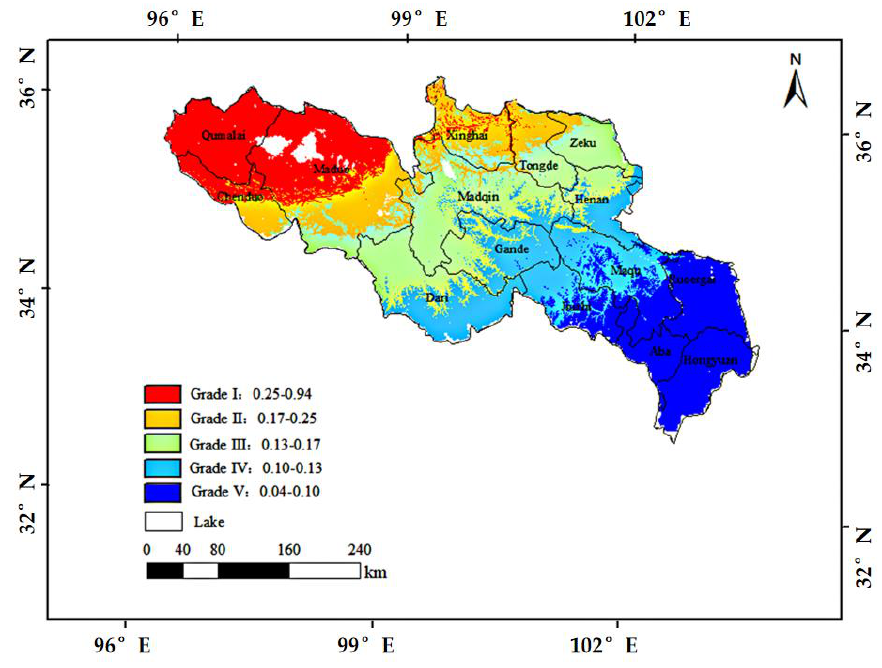
Figure 7. The importance of water conservation evaluation.